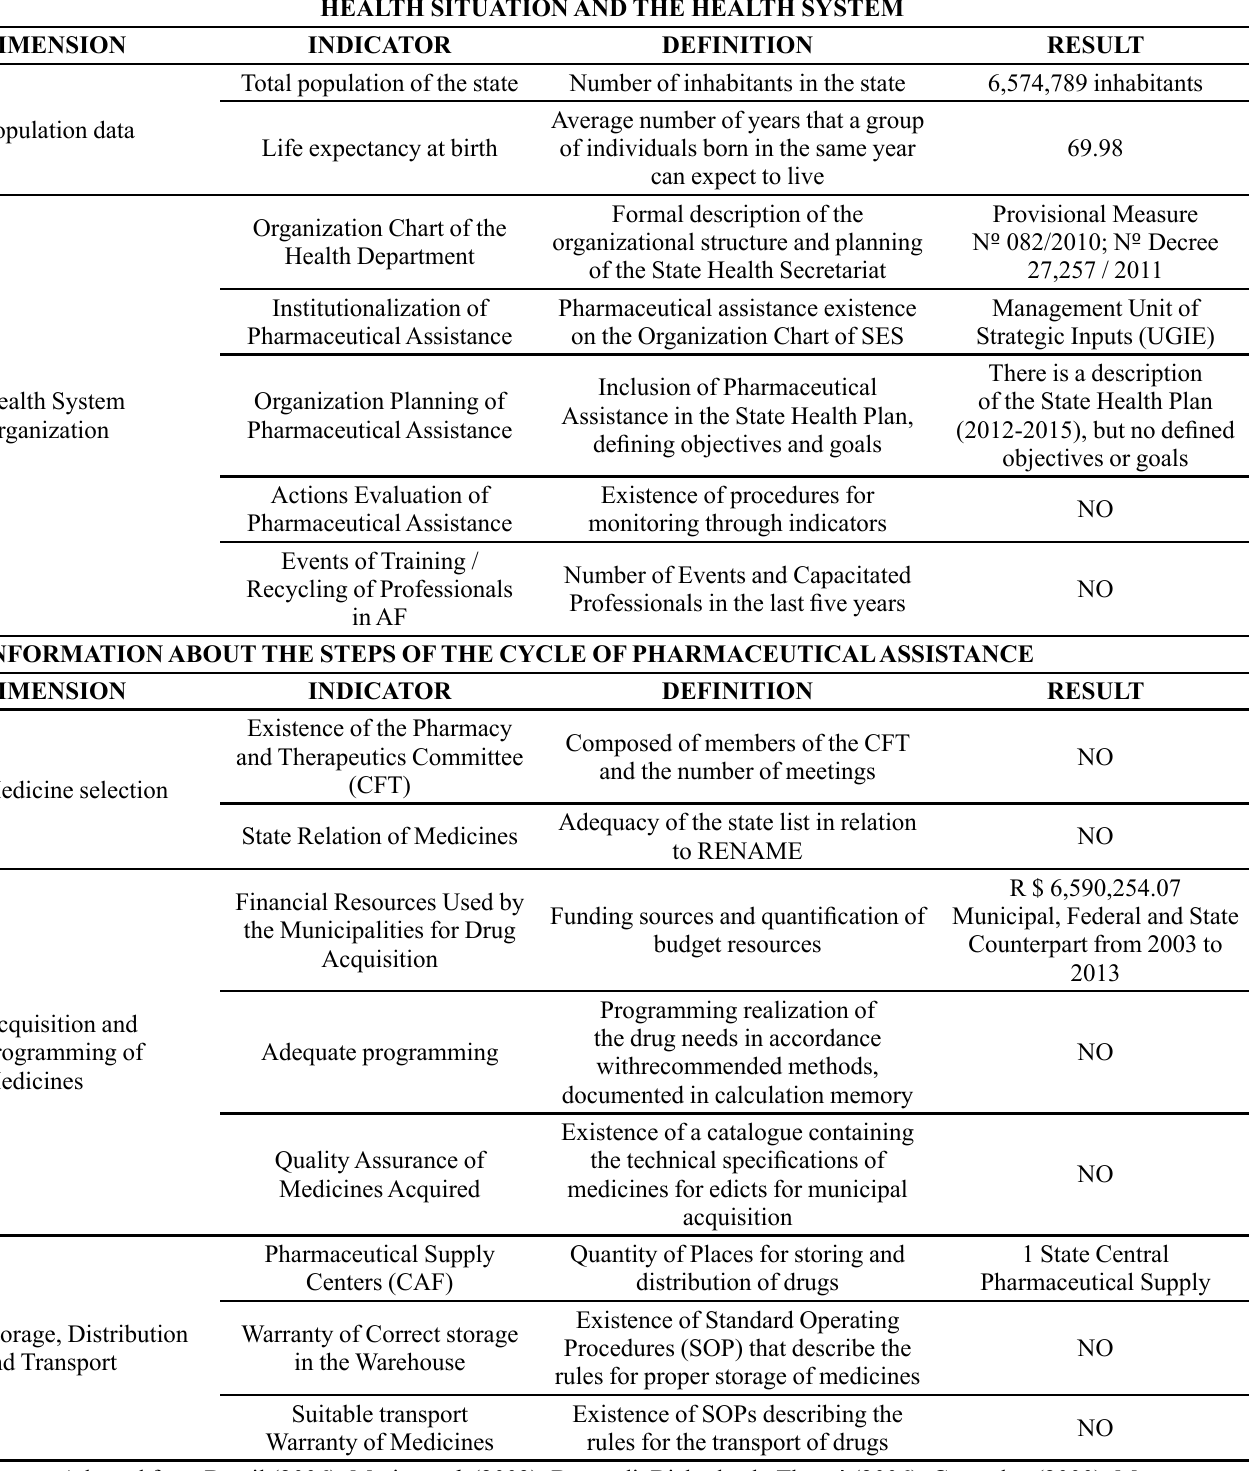
SOCIO-DEMOGRAPHIC INFORMATION